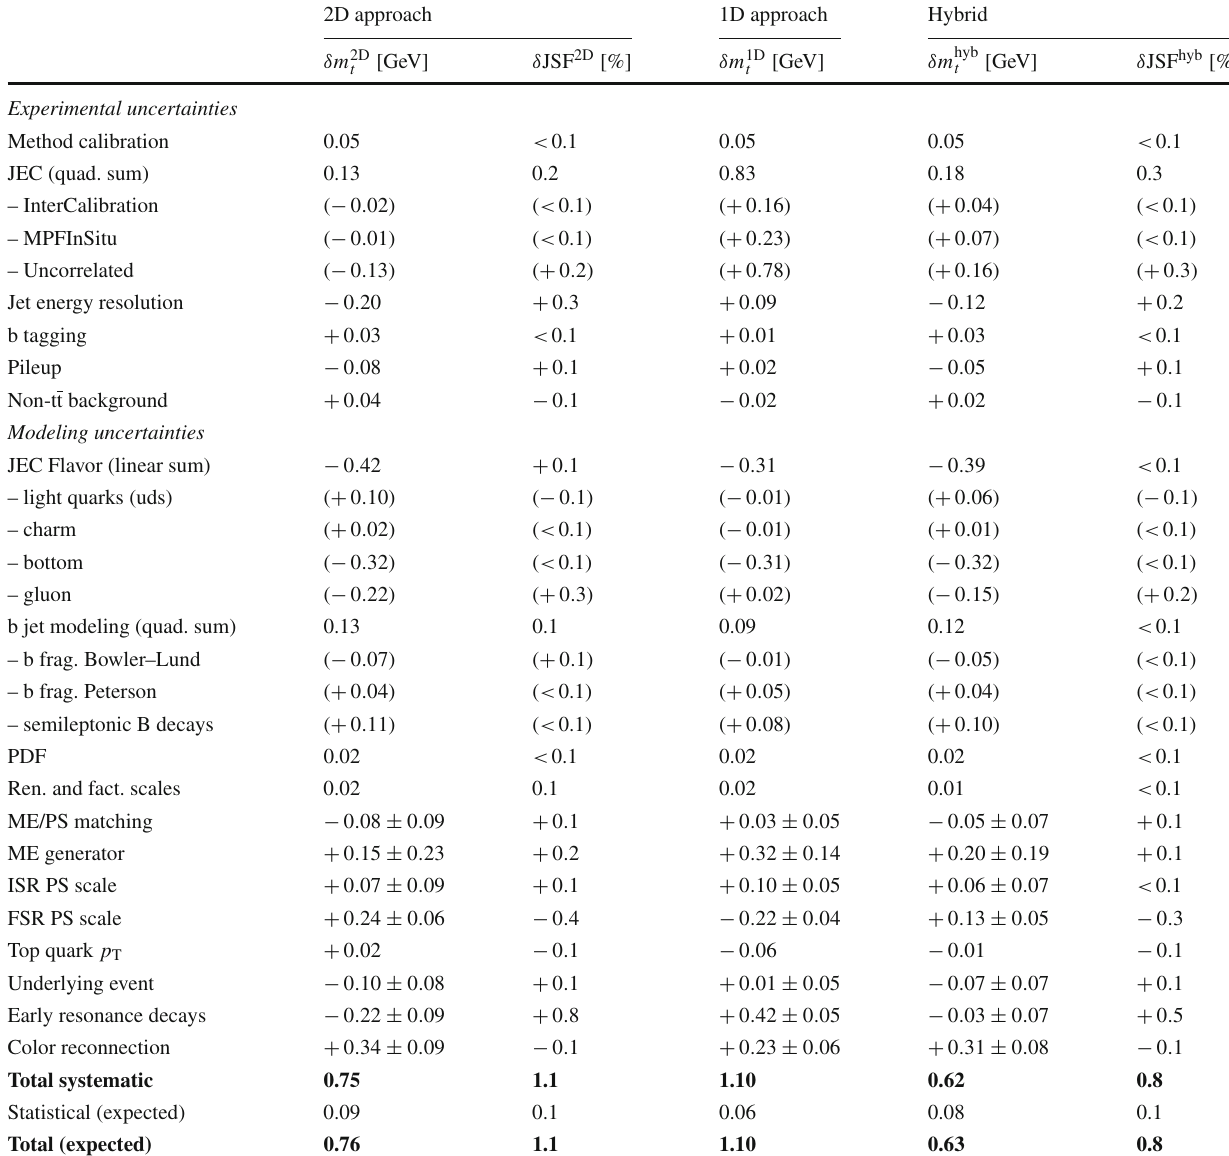
the preceding uncertainty source. A positive sign indicates an increase in the value of m t or the JSF in response to a + 1 σ shift and a negative sign indicates a decrease. The statistical uncertainty in the shift in m t is given when different samples are compared. The statistical uncertainty in the JSF shifts is 0.1% for these